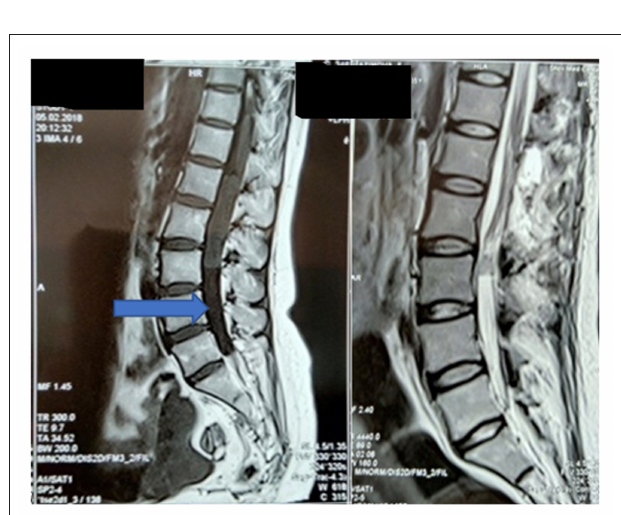
FIGURE 2 | MRI of the cervical spine, preoperative and 2 days post-surgery. A 36-year-old with a Neuroma on the ventral surface of the spinal cord, at the level of C1-C2 (blue arrow). Control MRI shows total tumor removal using an improved method (orange arrow).